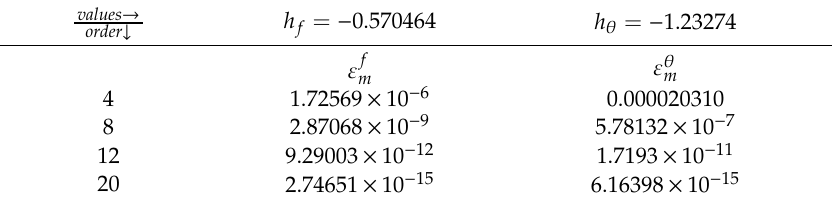
Table 3. Discrete residual square errors for ε f m and ε θ m